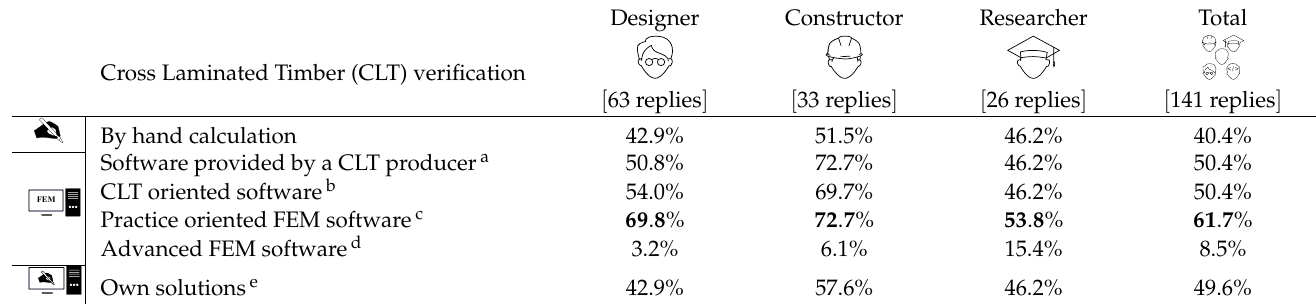
Table 5. Approach for cross laminated timber (CLT) verification (multiple choice). Legend: a